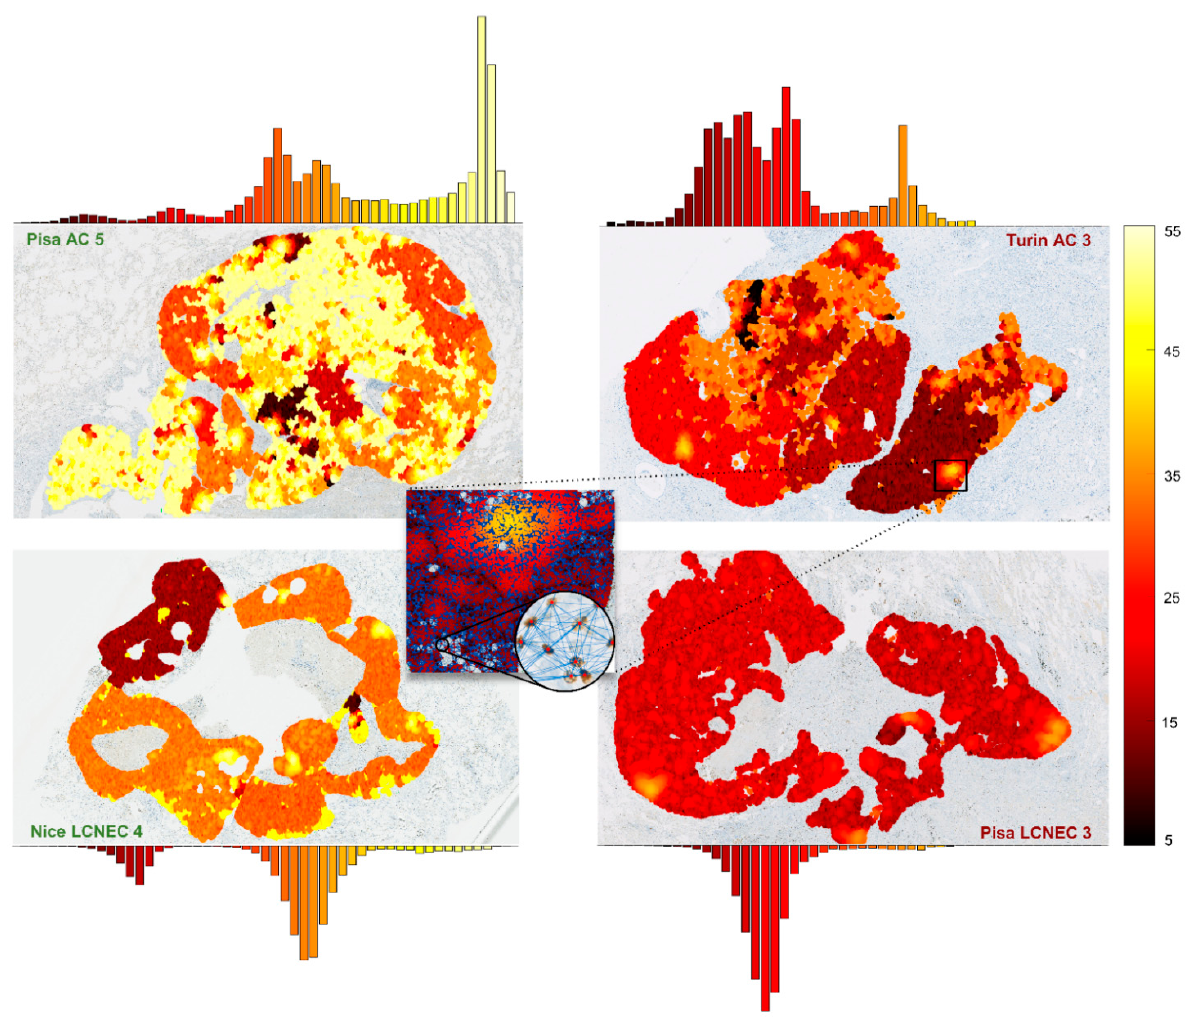
Figure 7. Eigenvector centrality value of each node in four samples in respective 75 µ m graphs. The samples presented include two GP, name in green, and two PP, name in red. Each image is paired with the corresponding histogram of centrality values. Higher values—i.e., lighter colour shades—indicate a greater relevance of the node in the network’s topology. For visualisation purposes, the measure presented is a transformation of the original eigenvector centrality value c eig , obtained for each node as c’ eig = log 2 ( c eig ) – min ( log 2 ( c eig )), with the minimum function computed over all nodes of that graph.